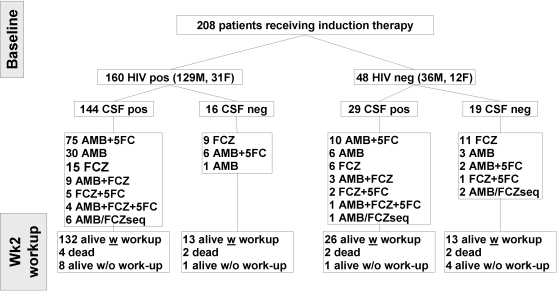
Flow chart showing the actual number of patients with cryptococcosis included in the description of clinical presentation, determinant of induction treatment choices and analysis of week 2 (Wk2) outcome.HIV-positive and -negative patients with cryptococcal meningoencephalitis (CSF pos) or with no proven central nervous system involvement (CSF neg) were enrolled in the prospective multicenter CryptoA/D observational study. The Wk2 workup requested control of sterilisation of the body sites infected with C. neoformans at baseline. Treatments prescribed for more than 5 days included amphotericin B (AMB), flucytosine (5FC) and/or fluconazole (FCZ). Overall, of the 208 patients eligible for analysis at baseline, at the time of the Wk2 workup, 184 were alive with mycological outcome assessed, 14 were alive without mycological evaluation and 10 had died.